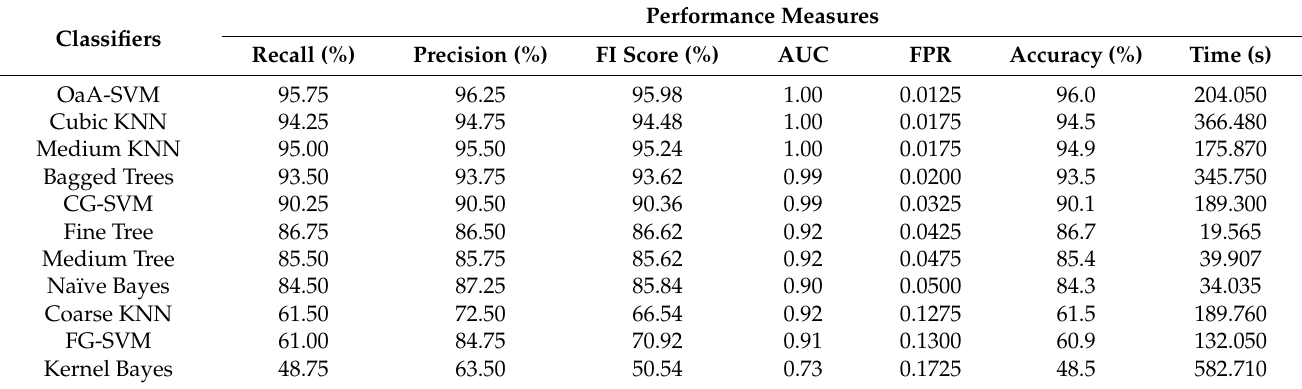
Table 1. Proposed gait-recognition results using real-time captured dataset for normal walk on selected